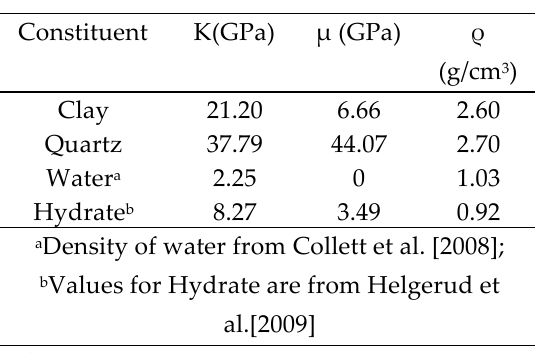
Table 1. Bulk moduli (K), shear moduli (µμ),